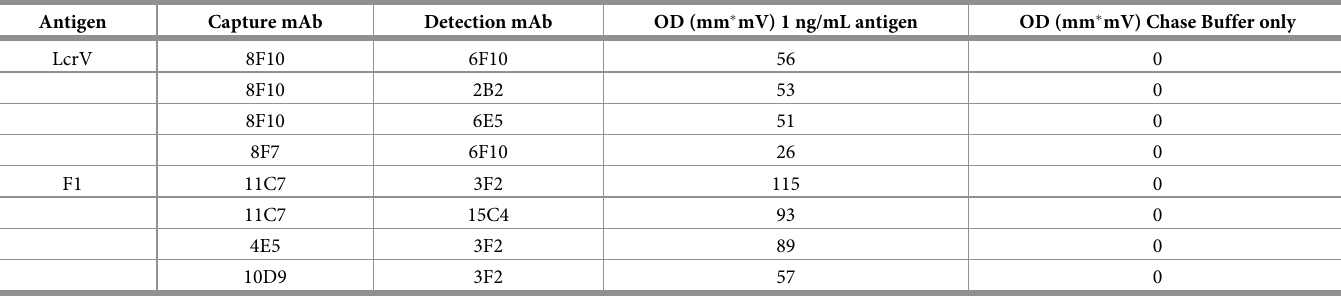
positive signal is observed in spiked pools of normal human sera (NHS). In this study, a posi- tive signal was defined as an intensity reading greater than 20 mm � mV using the Qiagen ESE Lateral Flow Reader. Due to sample variability, difference in assay performance was observed between each lot of pooled human serum. Six different pools of NHS were used to optimize each LFI prototype for nonspecific background signal. Then the pools were spiked with recom- binant protein and used to determine the LOD of the LFI prototypes to account for possible matrix effects on signal intensity. The LOD of the 8F10/6F10 LFI was estimated to be 2 ng/mL when recombinant LcrV was spiked into NHS (Lot NHS207) (Fig 3A). The LOD of the 11C7/ 3F2 LFI was estimated to be 1 ng/mL when recombinant F1 was spiked into NHS (lot NHS207) (Fig 3B). Despite high analytical sensitivity to each antigen, differences of assay signal were Table 3. Assay sensitivity of the top 4 mAb pairs (LcrV or F1) by lateral flow immunoassay. Antigen Capture mAb Detection mAb